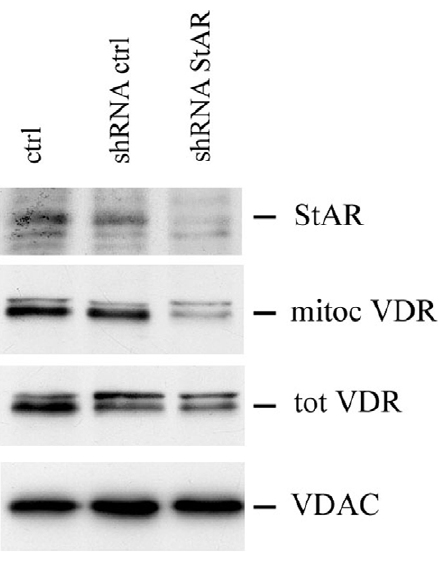
Figure 6. Effect of genetic silencing of StAR on VDR expression. Subconfluent HaCaT cells were infected with lentiviral StAR shRNA particles to silence the endogenous StAR expression. Mitochondrial fractions from untreated HaCaT (ctrl) and cells infected with shRNA control and StAR were analysed by western blotting for StAR and VDR expression. VDR levels were also evaluated in total lysates. VDAC was used as internal control for protein loading. Figure S1 Analysis of mitochondrial translocation of VDR in presence of cyclosporin A. HaCaT cells were treated with cyclosporin A (CsA), cycloheximide (CHX) or 100 nM 1,25D3 (Vit.D) as indicated and 30 m g of mitochondrial proteins were analysed by western blotting for VDR, RXR a and p53 expression. VDAC was used as internal control for protein loading. A representative blot is shown. (TIF) Figure S2 Effect of squalestatin treatment on StAR and VDR expression. HaCaT cells were treated with squalestatin (SQ) and 100 nM 1,25D3 (D) or left untreated (control, C), harvested and 50 m g of total lysates (tot) or 30 m g of mitochondrial proteins (mit) were analysed by western blotting for StAR and VDR expression. VDAC or actin expression were evaluated as loading control. A set of representative blots is shown. (A) Analysis of StAR expression in mitochondrial fractions. (B) VDR expression after squalestatin treatment in a time course experi- ment. (C) VDR expression after 72 hours of the same treatments as in (A). (TIF)